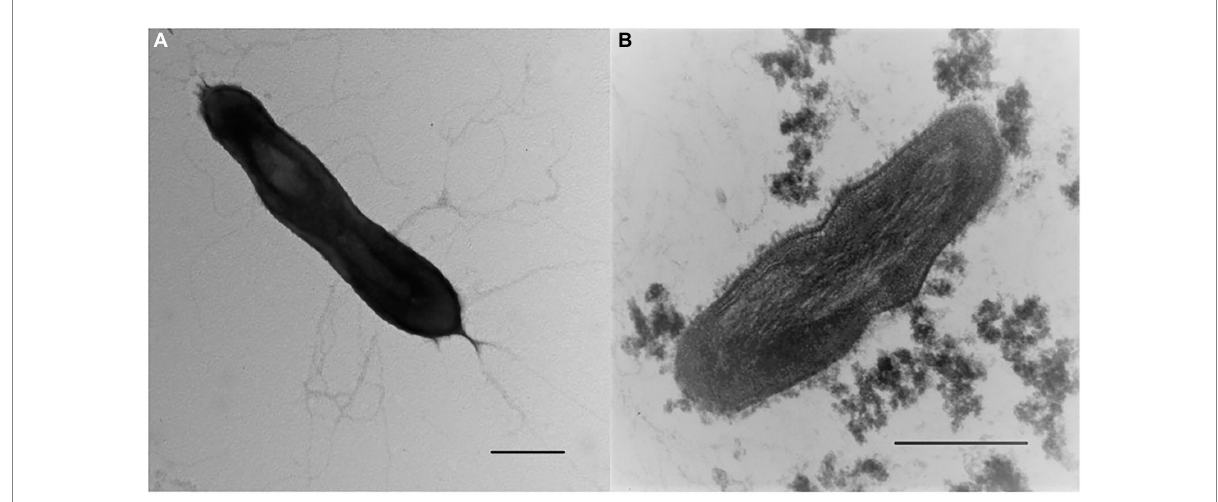
FIGURE 2 Cellular morphology of strain M08DHB T . (A) Electron micrograph of negatively stained cells showing an overall cell morphology and localization of filamentous appendages around a cell. Bar, 0.2 μ m. (B) Ultrathin section of a cell, showing thick bilayered cell-wall structure. Bar, 0.2 μ m.